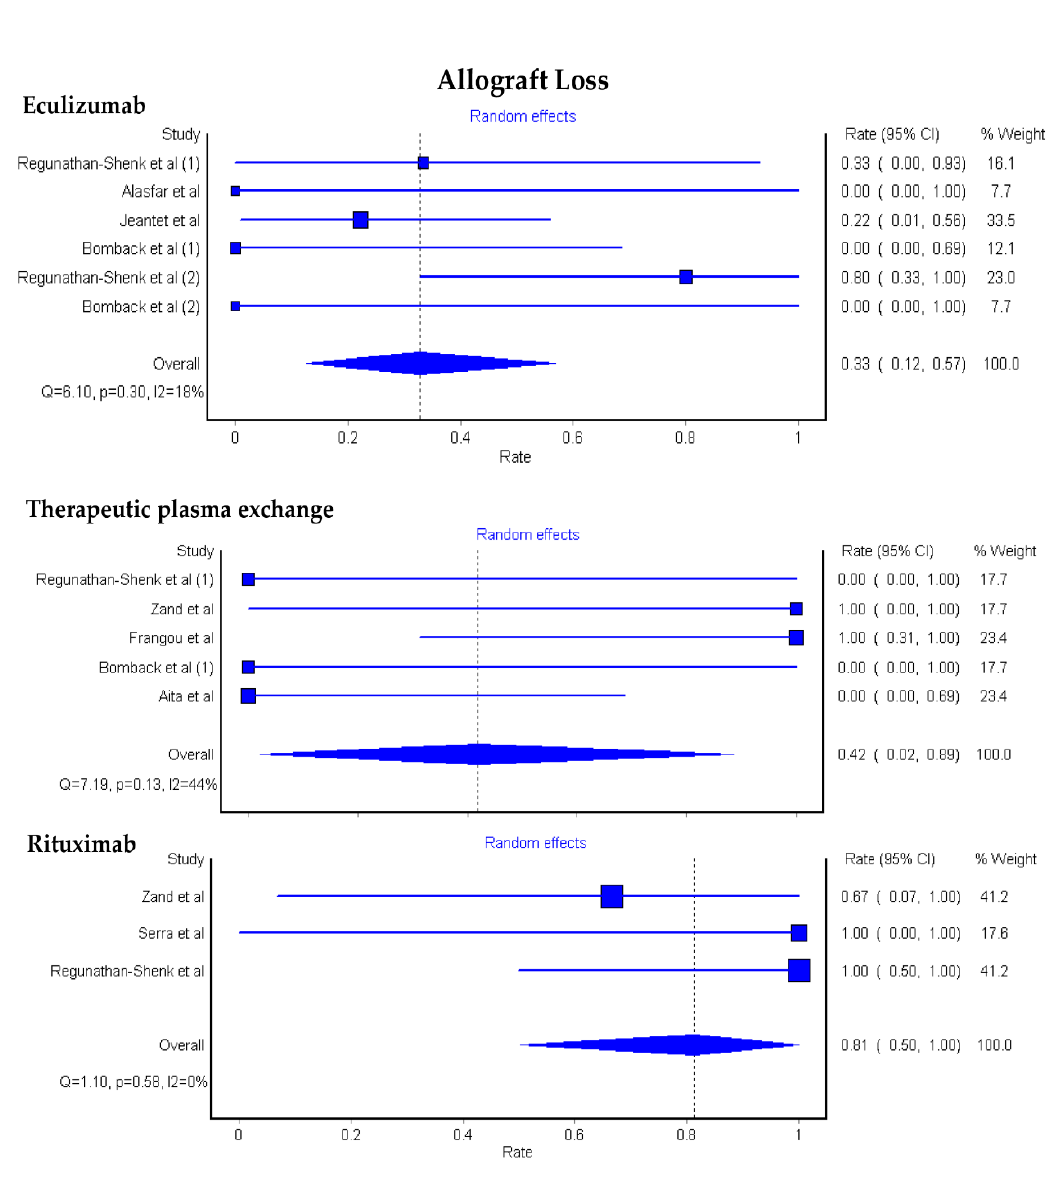
Figure 2. Pooled estimated rates of allograft loss among KTx patients with C3G.